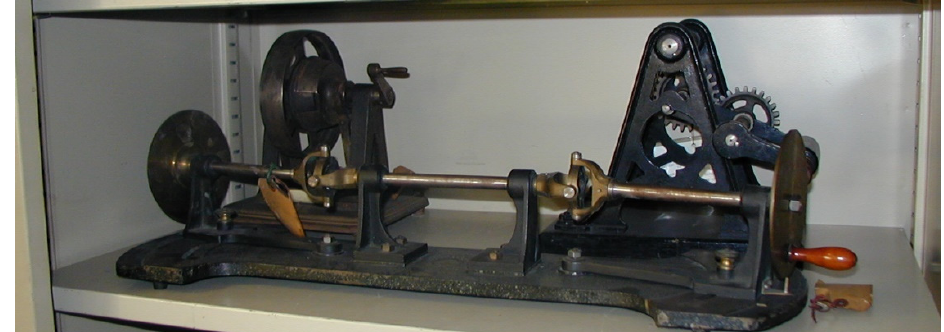
Figure 18. The iron-made model of axle transmission with Cardan joints.